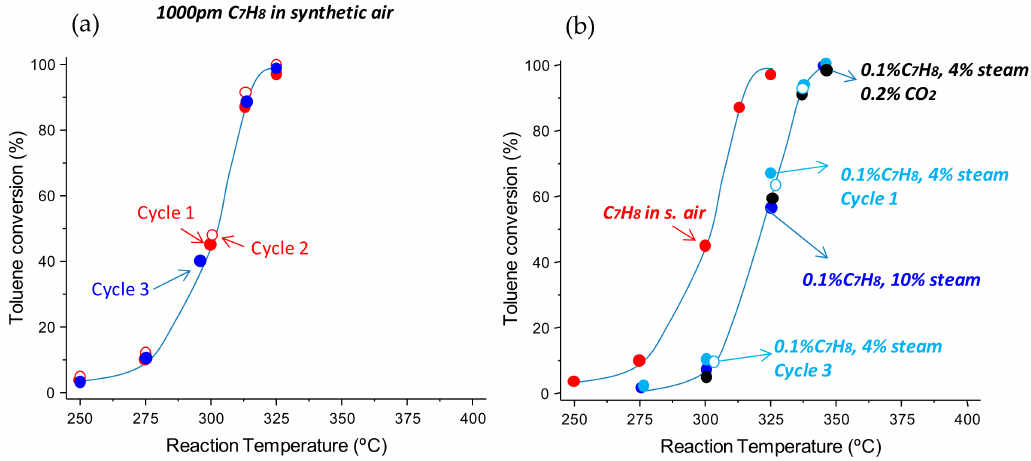
Figure 2. Evolution of the toluene conversion with the reaction temperature for Fe-ST2 catalyst: ( a ) stability after 3 catalytic cycles, ( b ) effect of the presence of water steam and CO 2 on the catalytic performance. GHSV = 300,000 h − 1 and remaining reaction conditions detailed in the